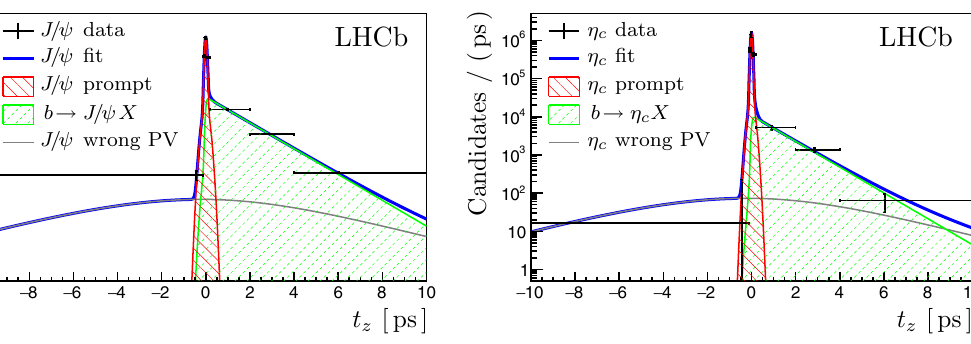
Fig. 7 Distributions of t z for (left) J /ψ and (right) η c mesons for the entire p T range 6 . 5 < p T < 14 . 0GeV and the result of the simultane- ous χ 2 fit. The solid blue lines show the fit function, the red dashed areas show the prompt components, the green dotted areas show the Fig. 8 Relative η c to J /ψ differential production cross-sections for (left) prompt production and (right) production in b -hadron inclusive decays obtained using the alternative technique (points) and the baseline technique (red boxes). The uncertainties shown are statistical, systematic, and the uncertainty due to the η → pp and J /ψ → pp c branching fractions